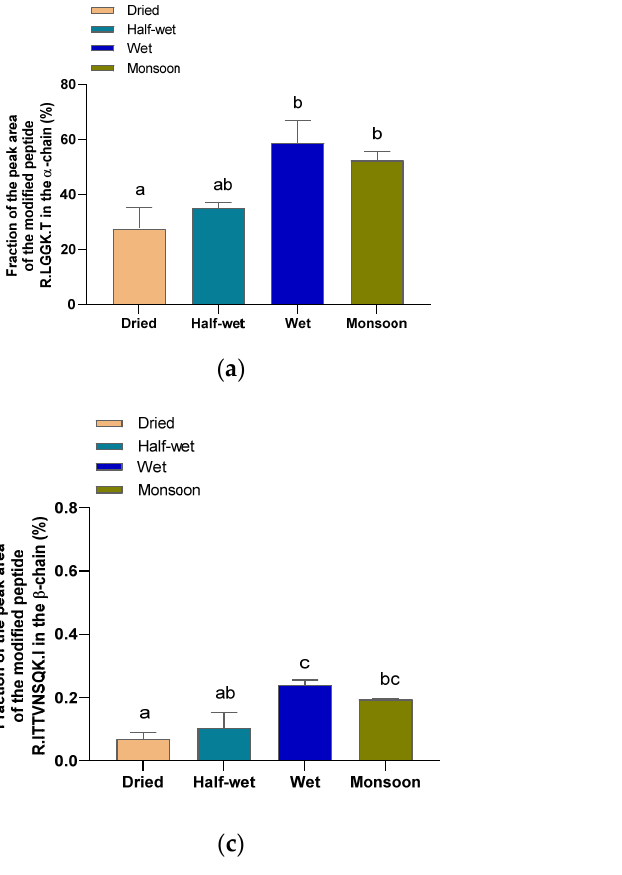
Figure 6. The proportion of modification of lysine residues in selected peptides of the α -chain ( a , b ) and β -chain ( c , d ) of the 11S storage protein as determined by HPLC-MS/MS. Different letters indicate significantly different values for each group ( p < 0.05, ANOVA, Tukey’s test). The peptides K.FFLANGPQQGGK.E and R.LGGK.T of the α -chain show a high level